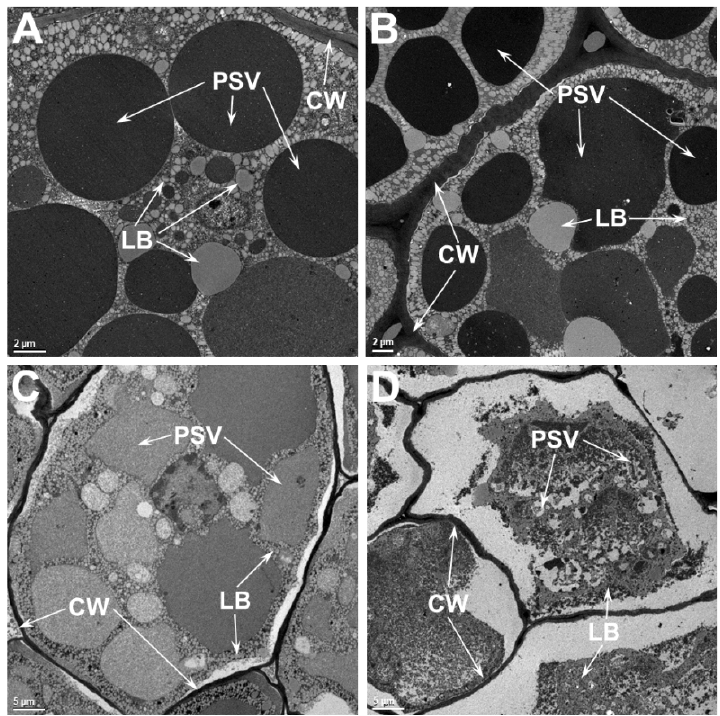
Figure 6. Transmission electron micrographs of tolerant ( A and C ) and sensitive ( B and D ) soybean genotypes that were grown at different temperatures. Micrographs of soybean cotyledons that were grown at 36/24 °C ( A and B ) or 42/26 °C ( C and D ) day/night temperatures. Numerous protein storage vacuoles and lipid bodies are observed in these cells. Note the distorted appearance and size of protein storage vacuoles in the cotyledonary cells of the tolerant soybean genotype and the complete loss of internal structural organization in the sensitive genotype grown at 42/26 °C ( C and D ), respectively. PSV, protein storage vacuoles; LB, lipid bodies; CW, cell wall.